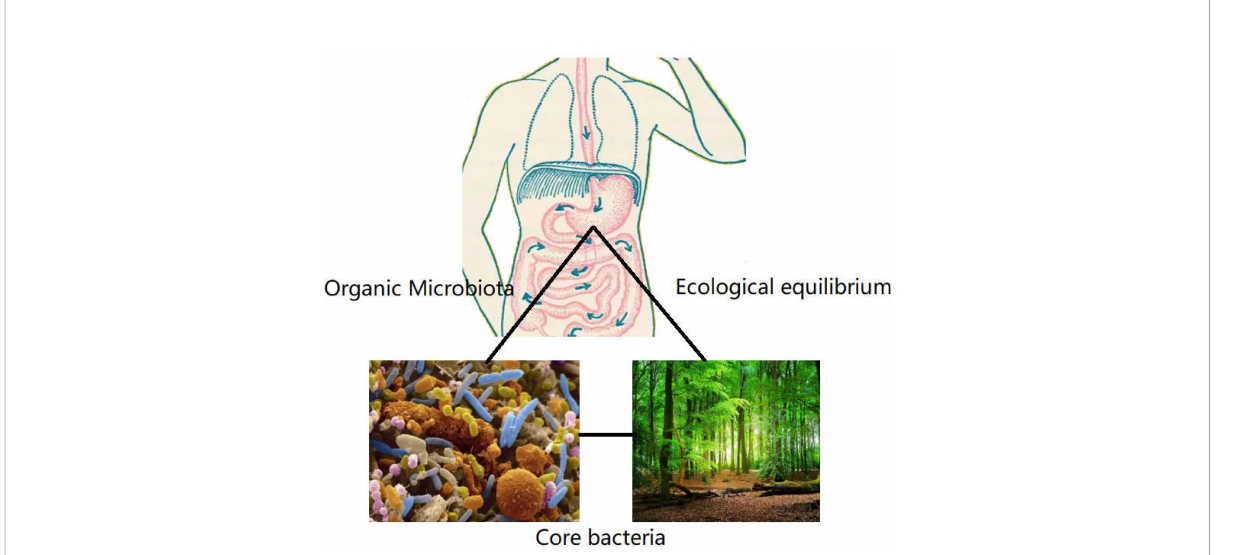
FIGURE 2 The role of core bacteria in organs. Organs such as mouth, gastrointestinal tract, lung, and genitourinary tract harbored many strains of bacteria, like the virgin forest existing many fl oras. The core bacteria were the exuberant fl oras, which presided in the microbiome. Although the number of core bacteria covered a few proportions in total fl ora. The function was the biggest in defending the equilibrium of microecology, which was essential to establish the dominate bacteria in